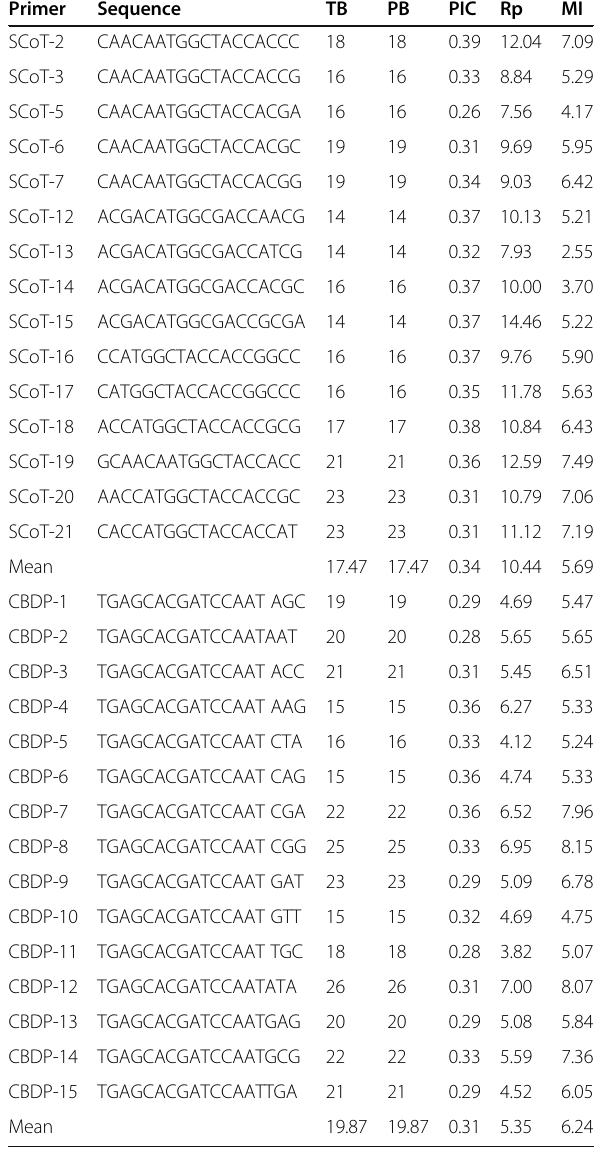
Table 2 List of used SCoT and CBDP primers and their calculated informativeness parameters on 91 investigated Triticum and